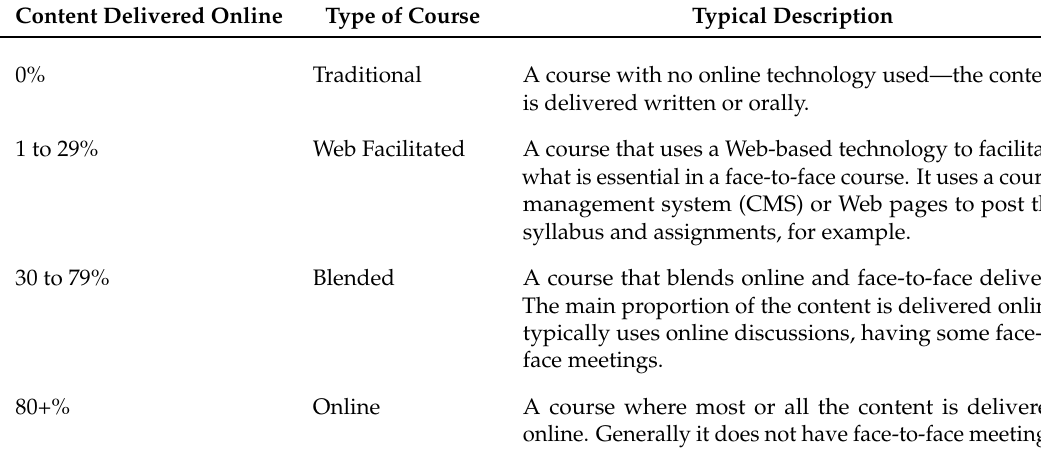
Table 1. Classifications of blended learning retrieved from [18].